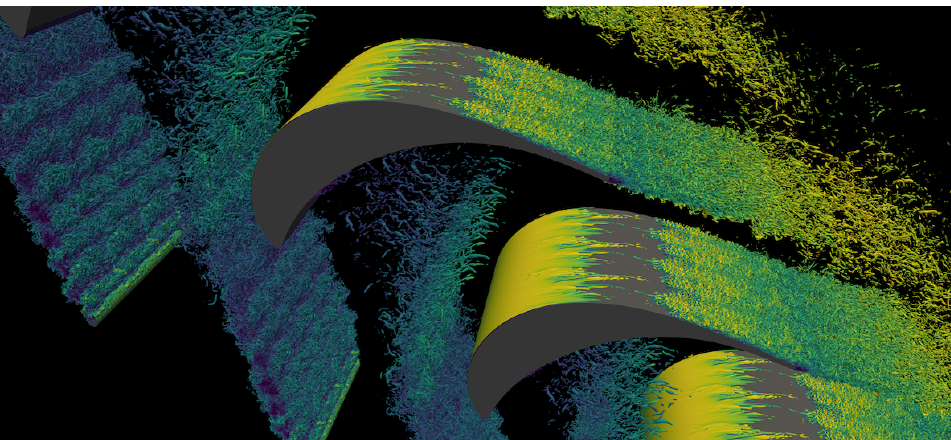
Figure 2. Iso-surfaces of Q-Criterion ( Q = 200) contoured by velocity magnitude in case Re 2 = 297,000. The computational domain is duplicated for graphical